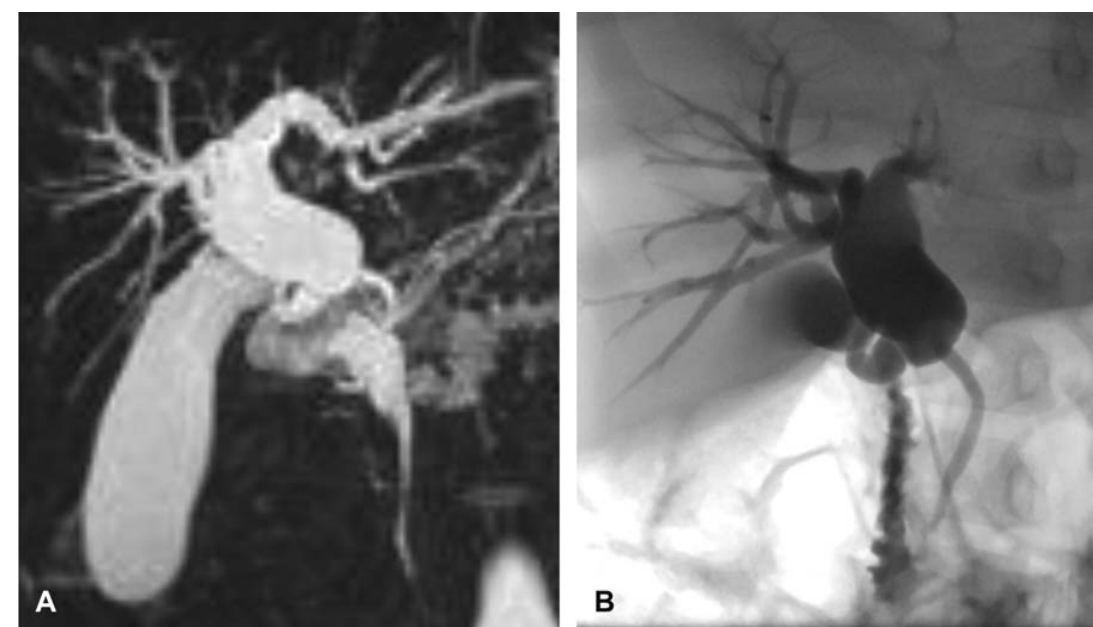
Fig. 2 Case 2: preoperative MRCP ( A ) and ERCP ( B ) images of dilated proximal CBD. Note the normal distal CBD and absence of a CC. CBD, common bile duct; CC, common channel; MRCP, magnetic resonance